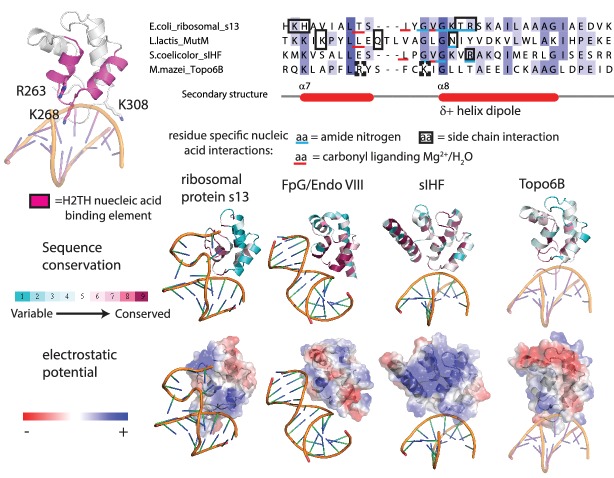
Comparison between H2TH domain homologs predicts a DNA-binding interface in Top6B.Representation of the H2TH domain with the nucleic-acid-binding element colored pink, potential DNA-binding residues labeled, and DNA model based on a DNA-bound sIHF structure (top left). Structural comparison reveals ribosomal s13 (PDB ID = 4YBB), MutM (PDB ID = 1TDZ) and sIHF (PDB ID = 4ITQ) bind DNA or RNA through interactions with main chain amide nitrogens (blue underline) or bridging H2O or Mg2+ liganded by main chain carbonyl oxygens (red underline). Side chain interactions (black box) are poorly conserved (top right). Nevertheless, the nucleic-acid-binding interface (middle) and electrostatic surface (bottom) is maintained within each family and aided identification of the H2TH point substitutions shown in Figure 3F.